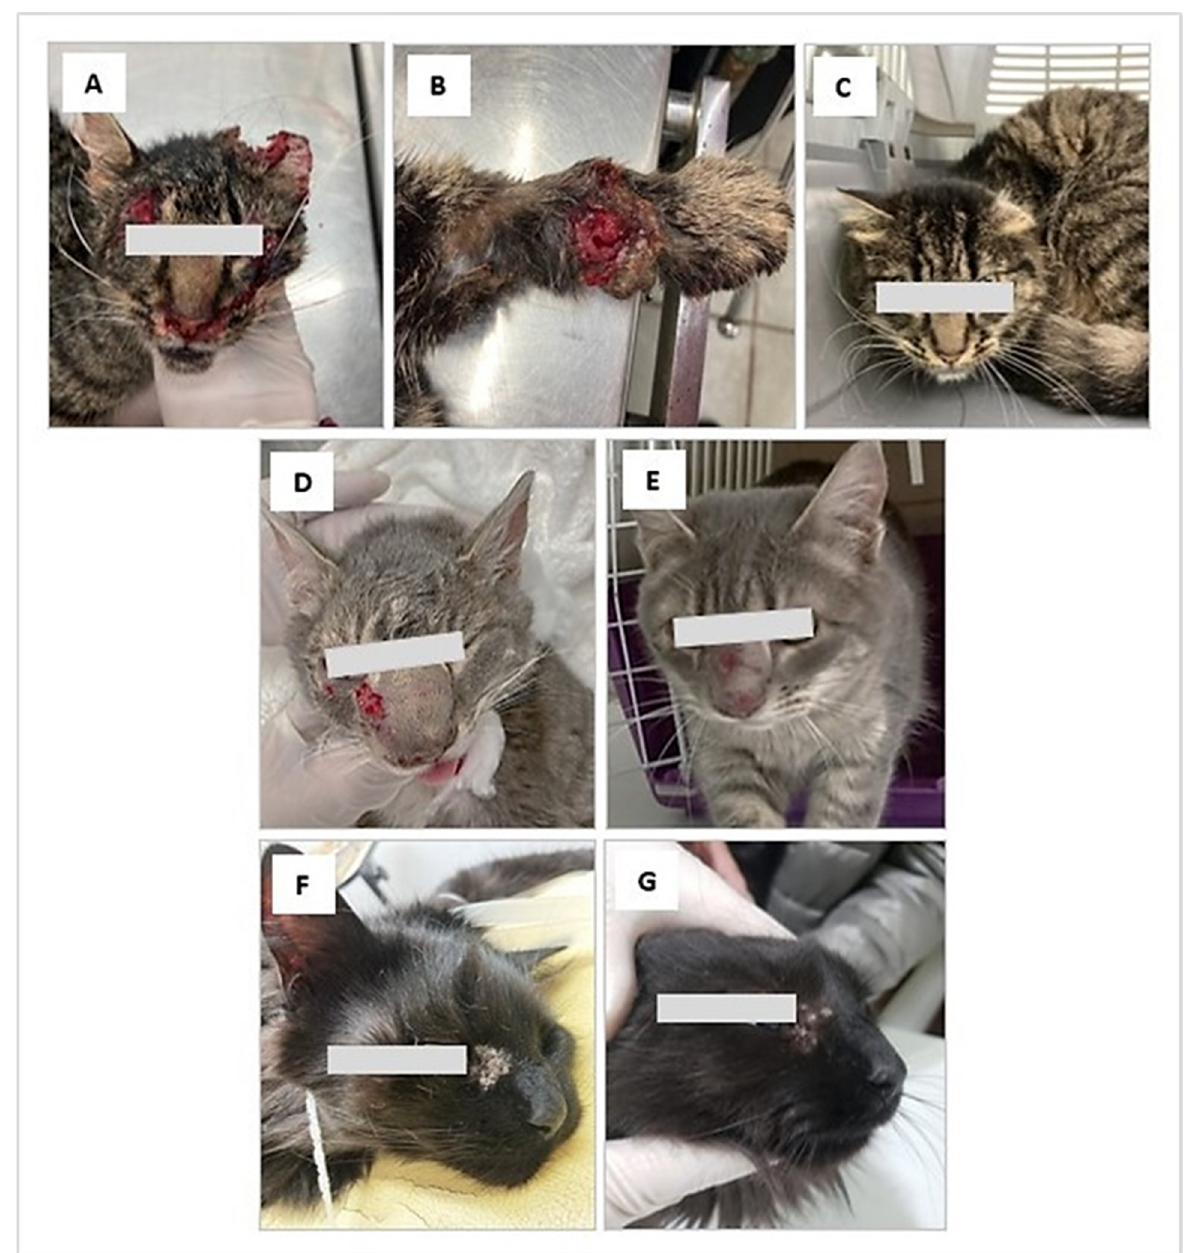
Figure 1. Clinical aspect of feline sporotrichosis. ( A , B ) Ulcerated lesions in the cephalic region and forelimb, associated with laceration of the left ear. ( D ) Subcutaneous, sero-bloody erosions located on the face near the eye, with inflammation and deformation of the nasal septum. ( F ): Periocular lesion with a moist and scaly appearance. ( C , G ). Clinical appearance of the lesions after treatment ( C ) A remarkable clinical cure is observed after 5 months of treatment with itraconazole ( G ) The evolution of treatment it is favorable after two months with treatment with itraconazole. ( E ) Appearance of lesions after 2 months of treatment with itraconazole and potassium iodide.